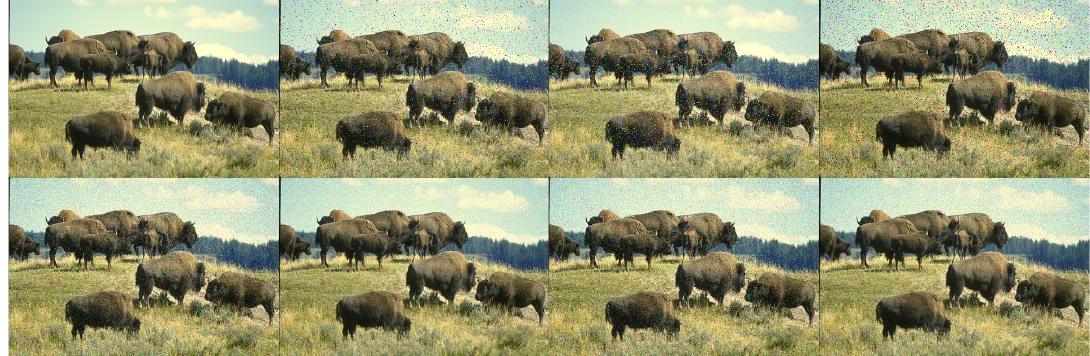
Figure 10. Different types of noise added to the herd image (label 38092 ). First row: Original image, salt&pepper noise added, salt noise added, pepper noise added; Second row: Gaussian noise added, Poisson noise added, speckle noise added, localvar noise